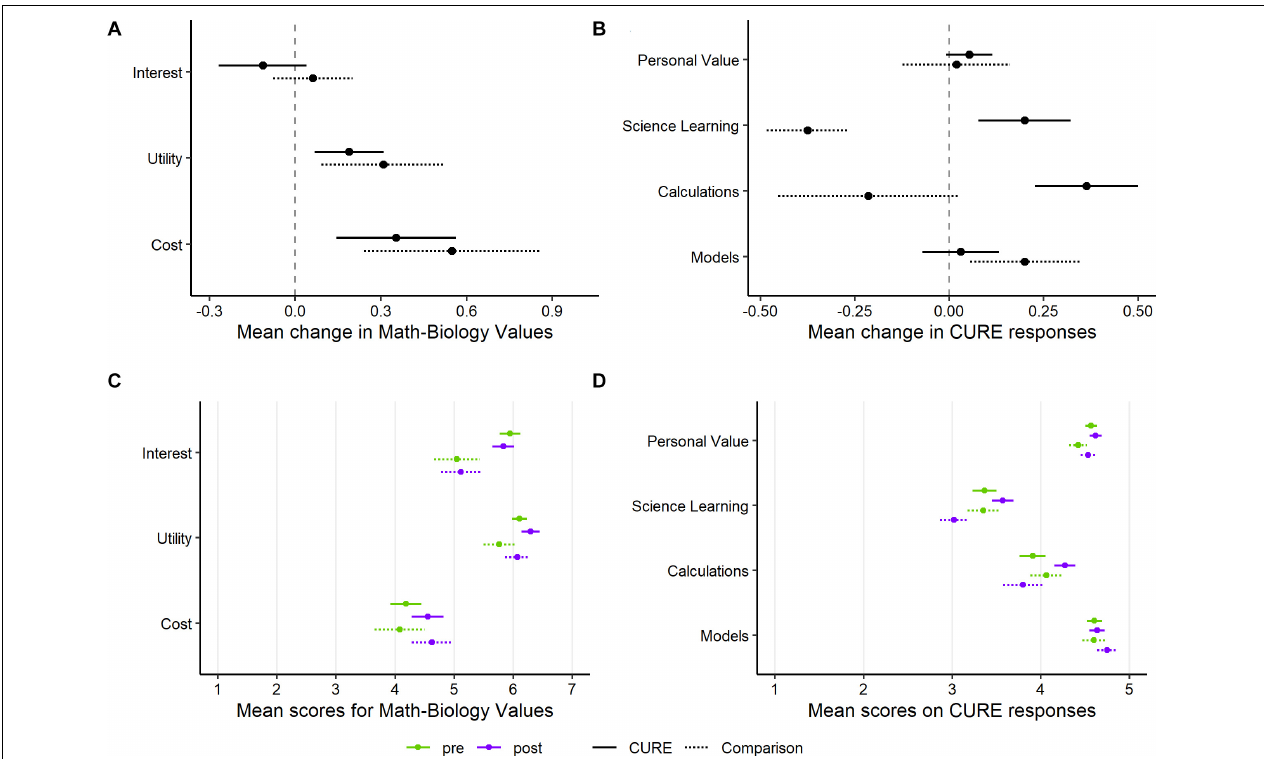
FIGURE 2 | Mean change (post score minus pre score) in student response between initial (pre) and end-of-quarter (post) survey, as well as mean pre and post scores, for several assessment instruments. (A) Change for each of the three constructs assessed by the Math-Biology Values Instrument, averaged over the questions for each construct. (B) Change for two constructs assessed by questions on the CURE survey, as well as two additional questions specific to quantitative thinking (Calculations, Models). (C) Initial (pre) and end-of-quarter (post) scores for the Math-Biology Values Instrument. (D) Initial (pre) and end-of-quarter (post) scores for CURE survey, Calculations, and Models. Students in both the CURE and comparison groups had very high initial scores for Interest, Utility, Personal Value, and Models, limiting the potential to observe positive changes. Green indicates the initial (pre) survey scores and purple indicates the end-of-quarter (post) scores. Points show the mean and lines show ± the standard error of the mean (SEM) within each group, question, and survey timing. Solid lines show SEM for CURE students, and dotted lines show SEM for comparison students. There are 33 students in the CURE group and 16 students in the comparison